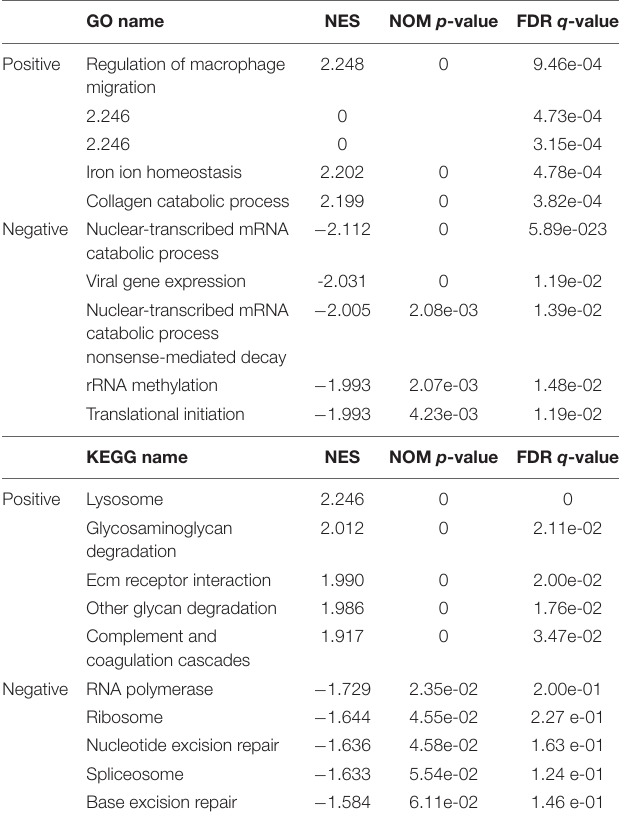
TABLE 1 | Most significantly correlated signaling pathways with matrix metallopeptidase 14 (MMP14) expression, based on their normalized enrichment score (NES) and P- value (top five